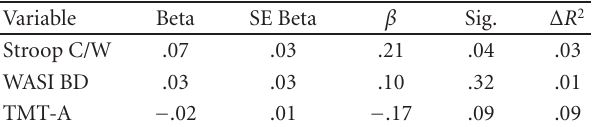
Table 4: Association of cognition with the